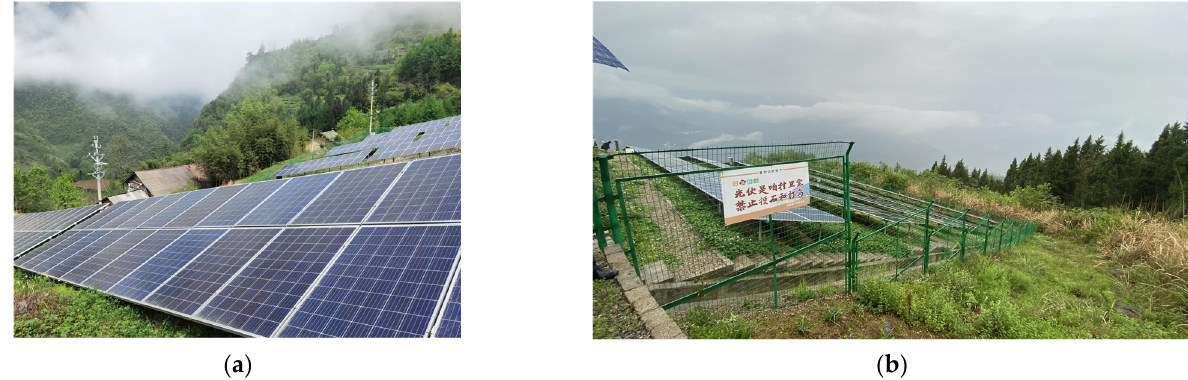
Figure 2. Photos of the Songjialiangzi power plant: ( a ) Frontal view; ( b ) Side view. (Writings in the figure are not relevant to the meaning of the figure).